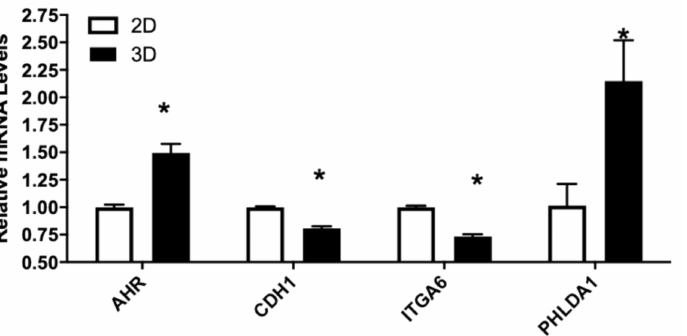
Figure 6. Relative mRNA levels of selected genes in LNCaP cells culture in 2D or 3D conditions. LNCaP cells were cultured in 2D or 3D conditions as described in Materials and Methods. RNA were isolated and gene expression determined using real-time RT-PCR, as described in Materials and Methods. Results were normalized to the untreated control and expressed as relative mRNA levels (mean ± SD, n = 3); p -values ≤ 0.05 were considered as significant and * indicates significantly different from